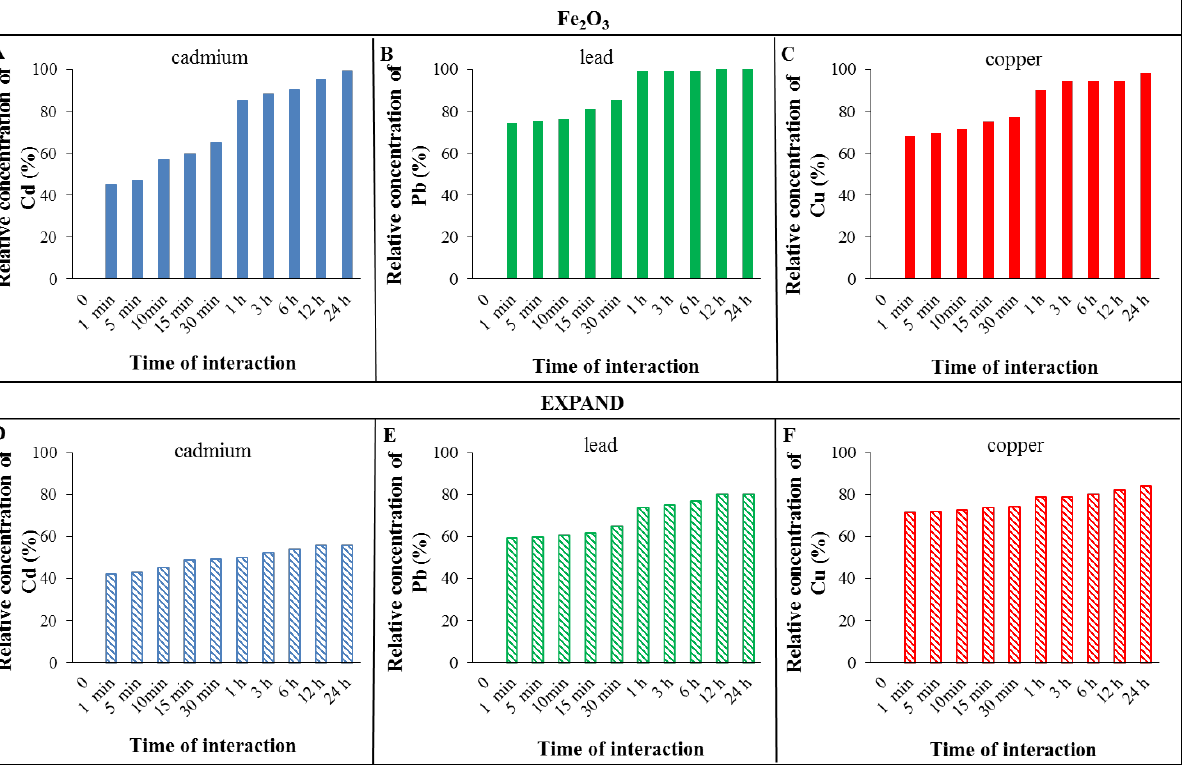
Figure 2. The amount of bounded cadmium ( A , D ); lead ( B , E ) and copper ( C , F ), on various adsorbents: ( A , B , C ) for Fe related to the applied concentration of metal (100 µM for cadmium, lead and copper). Zero on the x-axis is